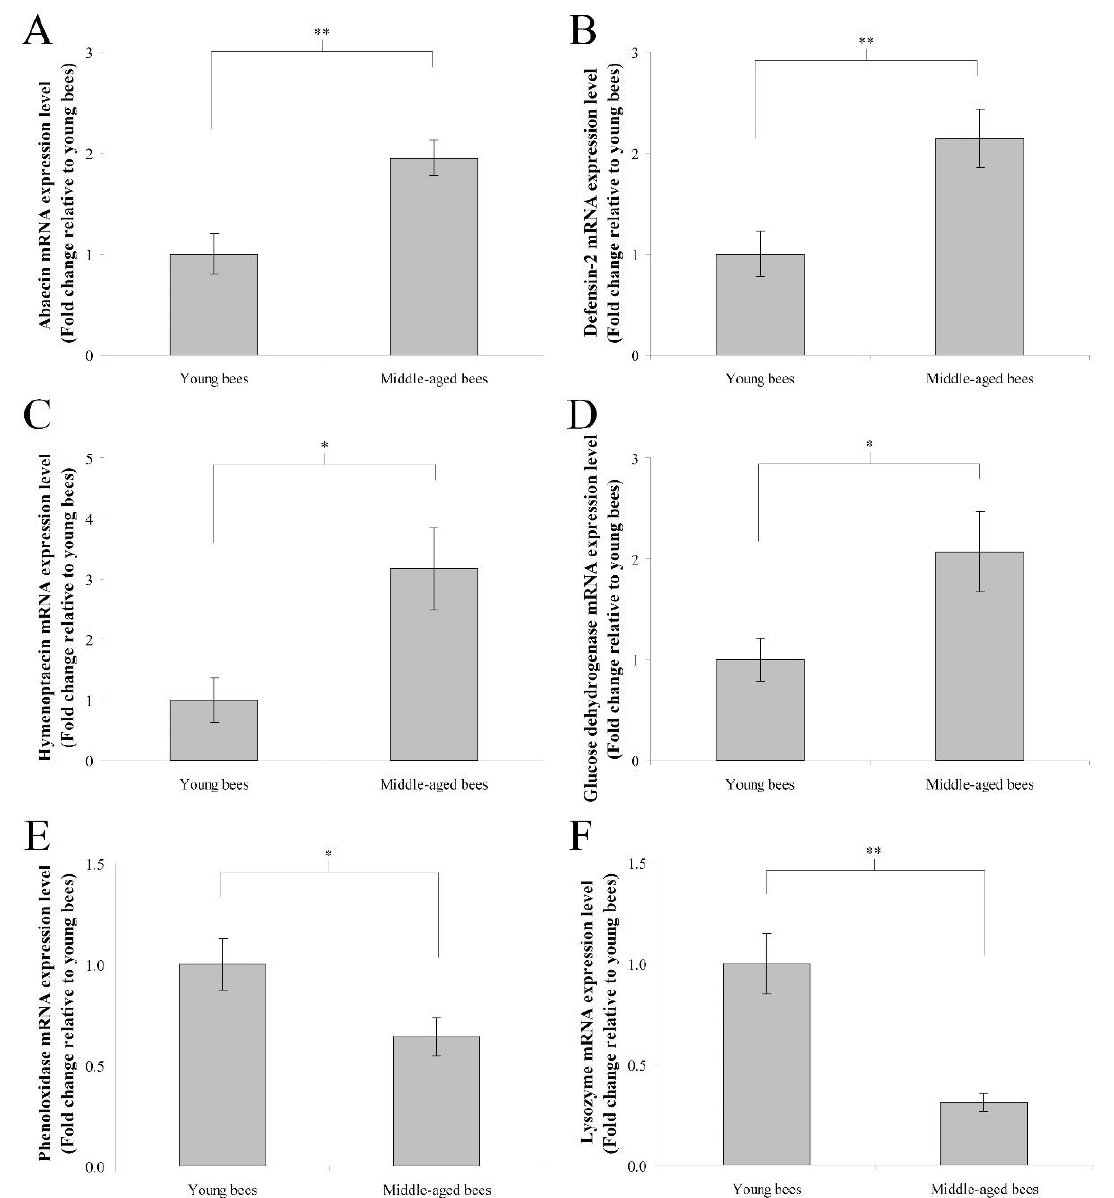
Figure 2. The genes expression of abaecin, defensin-2, hymenoptaecin, glucose dehydrogenase, phenoloxidase, and lysozyme from the whole body of young and middle-aged worker bees reared in an incubator. The mRNA expression levels of abaecin ( A ), defensin-2 ( B ), hymenoptaecin ( C ), glucose dehydrogenase ( D ), phenoloxidase ( E ), and lysozyme ( F ) genes were normalized to young worker bees and shown as fold changes, representing the mean ± SEMs ( n = 10). The asterisks indicate significant differences (* p < 0.05, ** p < 0.01; two-sample t -test).